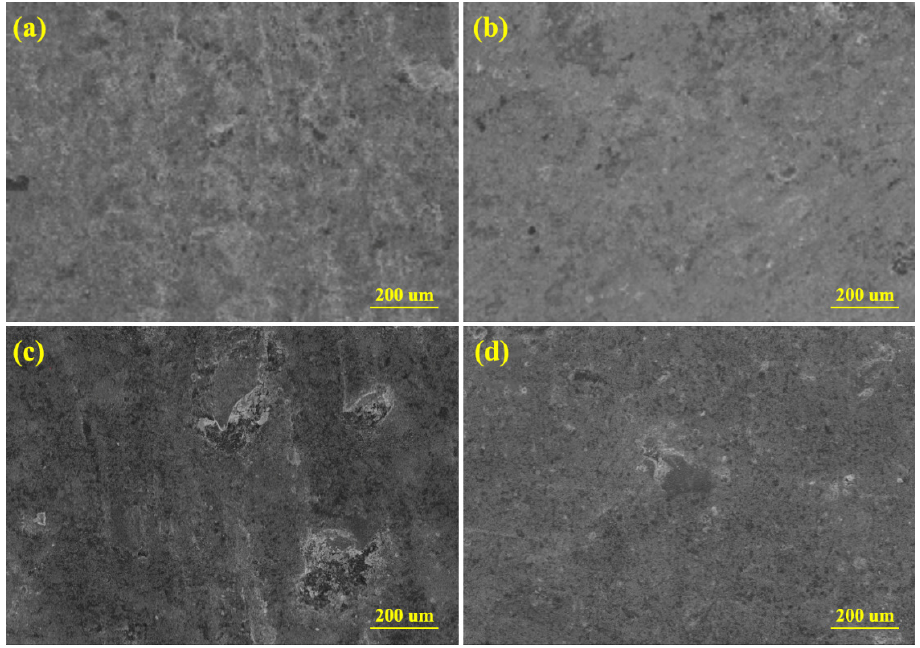
Figure 3. SEM micrographs of: ( a ) sample 1, ( b ) sample 3, ( c ) sample 5, and ( d ) sample 6.